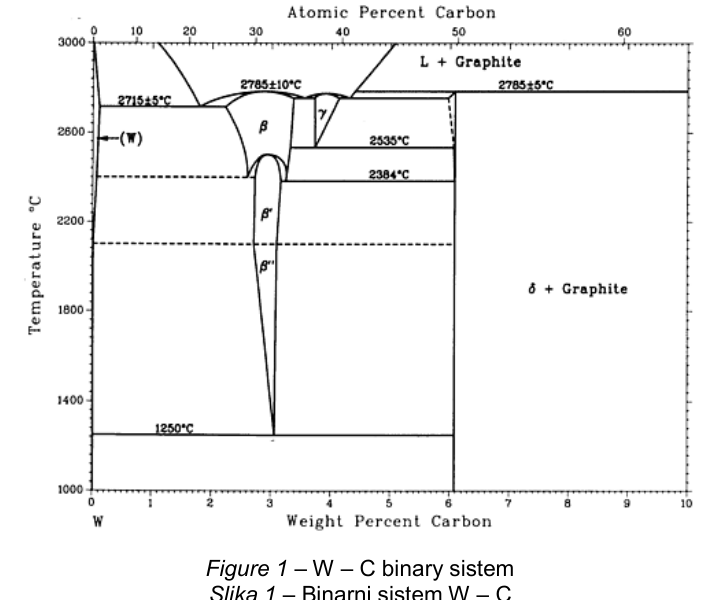
Figure 1 – W – C binary sistem Slika 1 – Binarni sistem W –